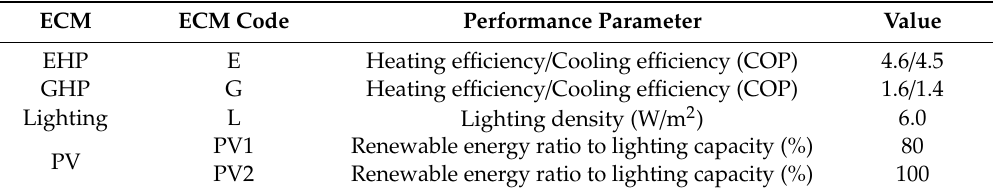
Table 9. Values of performance parameters for mechanical, electrical, and renewable ECMs.